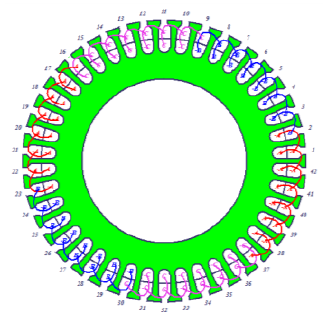
Figure 1. Connection diagram of three-phase windings.